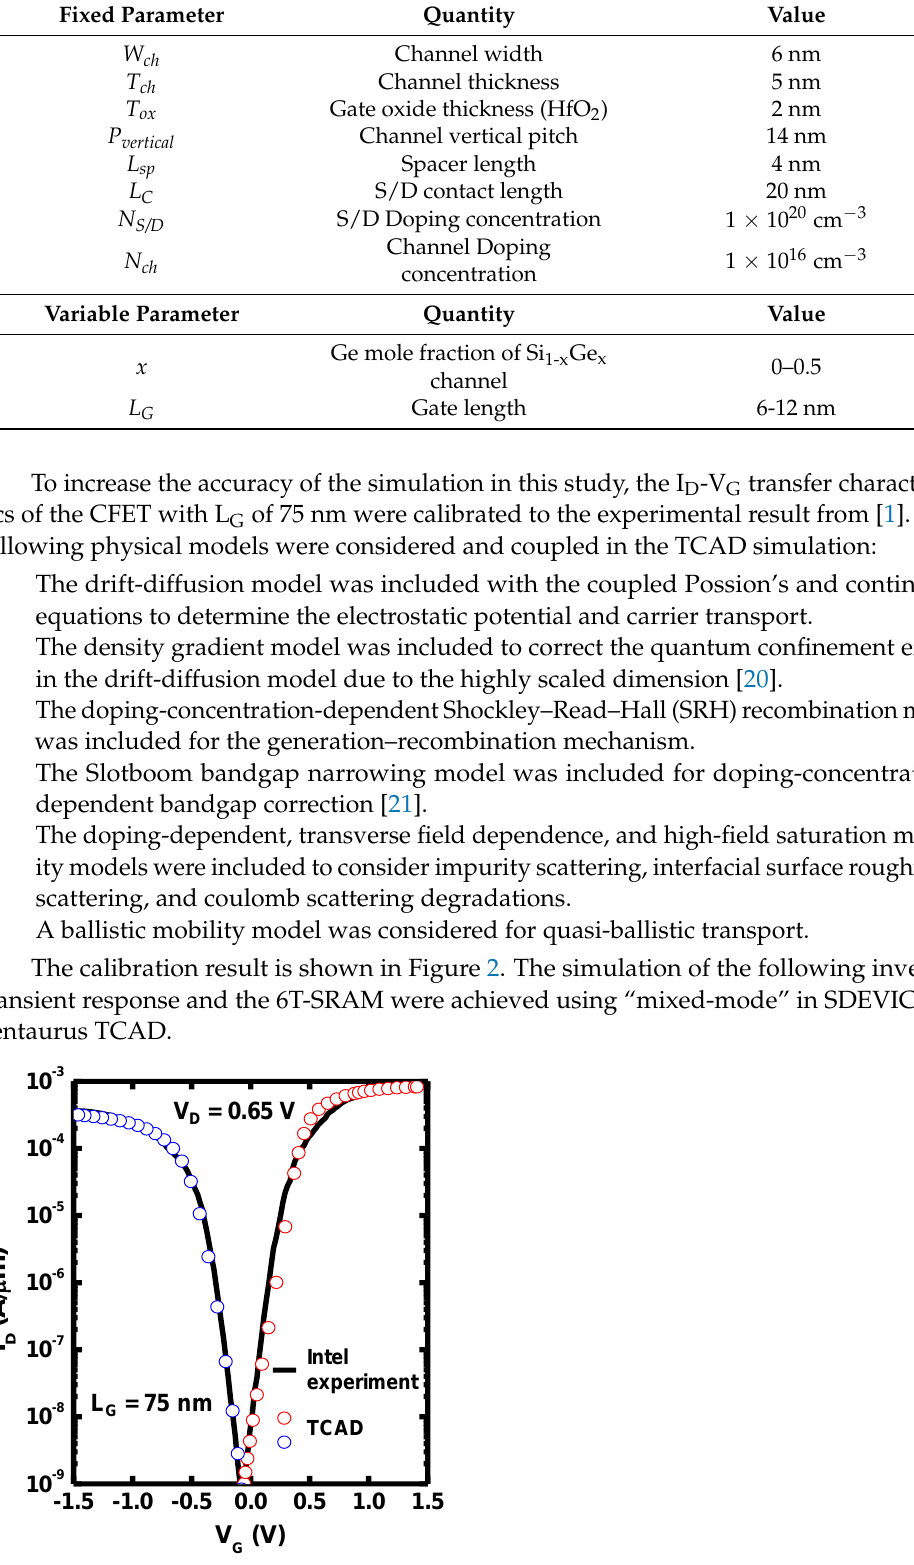
Figure 2. Calibrated I D -V G transfer characteristics of CFET between Intel experimental data [1] and TCAD